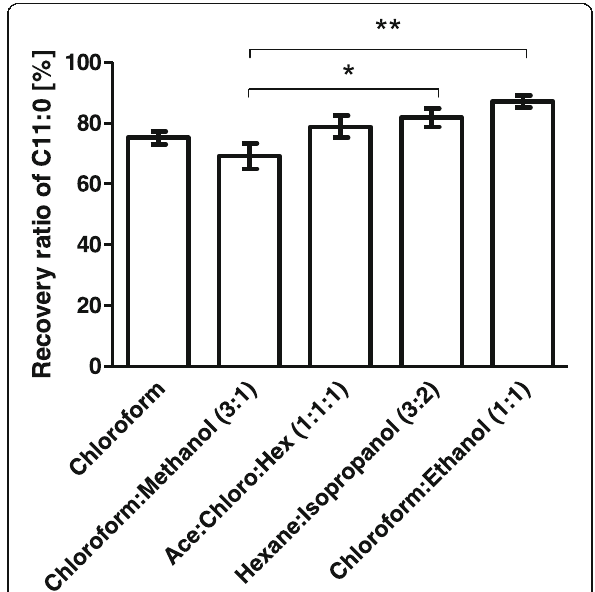
Fig. 4 Total quantity of fatty acids by using different organic solvents ( μ g of total fatty acids). Data are represented as means ± SEM. The p value is 0.011 ( n = 10, all donors). The one asterisk indicates 0.01 ≤ p <